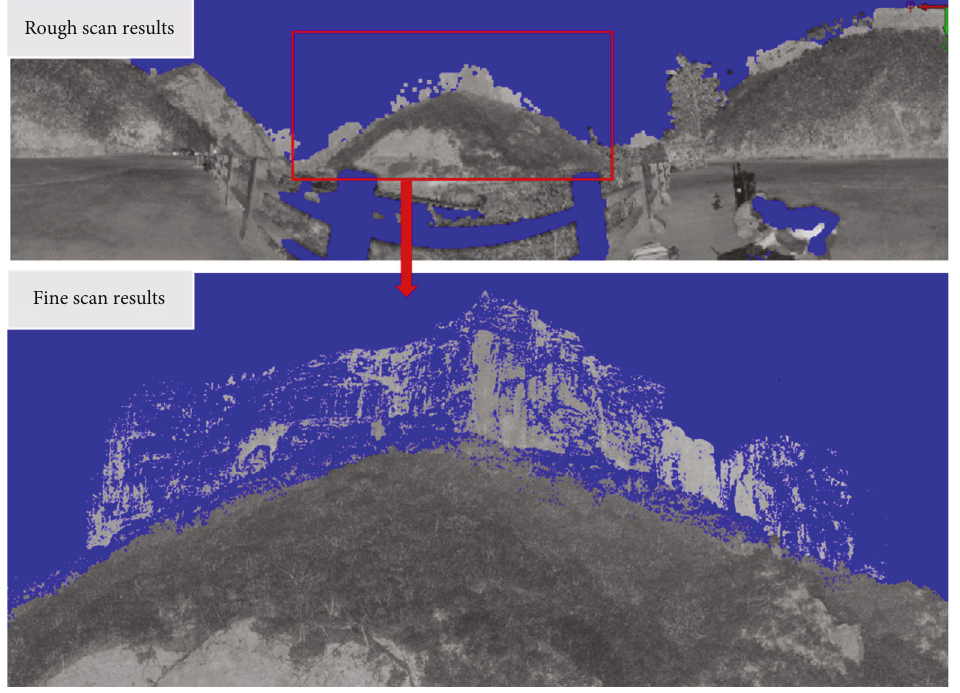
Figure 9: 3D laser scanner scanning